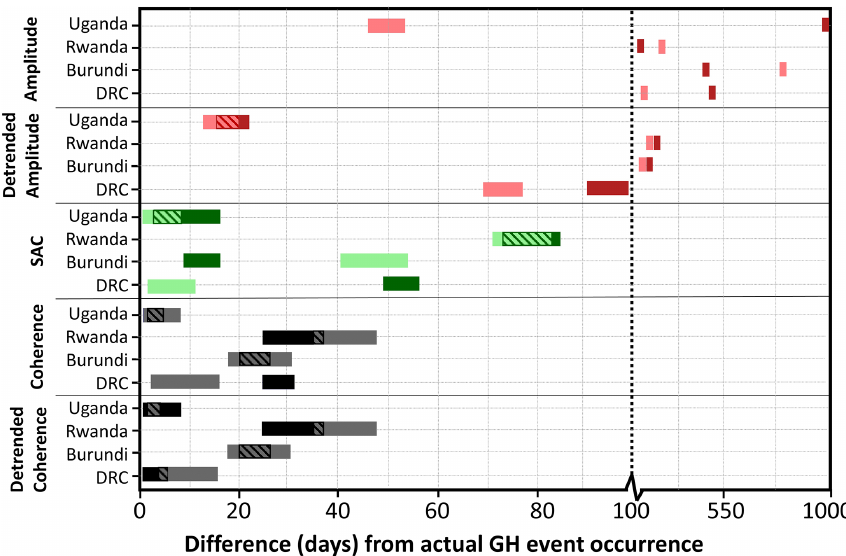
Figure 7. Estimated GH event timing using the complete GH event scale (workflow 1) for amplitude, detrended amplitude (red), SAC (green), coherence, and detrended coherence (black). The darker coloured bar represents the ascending track results. The lighter coloured bar represents the descending track results. The length of bars represents the uncertainty in timing (see Sect. 3.3). Dashed lines on the bars represent the overlap between the ascending and descending track results.